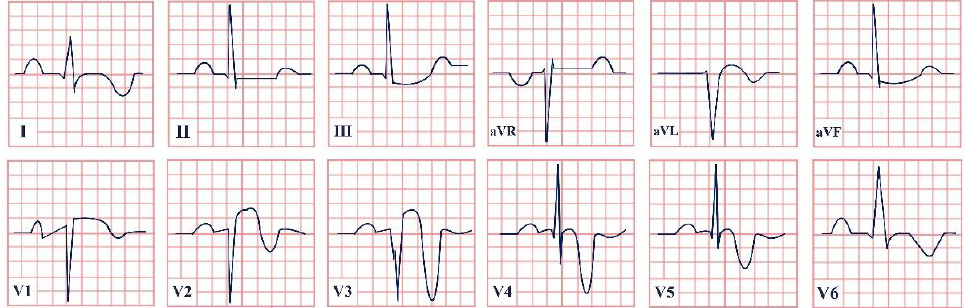
Figure 1. Electrocardiogram aspect in Wellen’s syndrome.